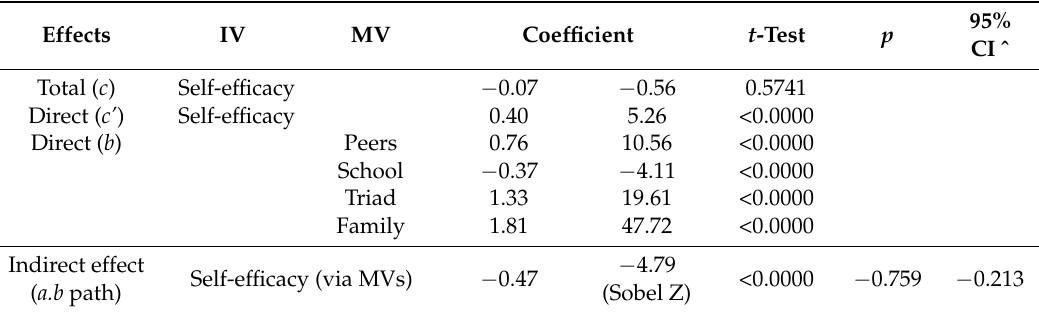
Table 7. Mediating analysis of contextual factors on the relationship between self-efficacy and violence of school students.